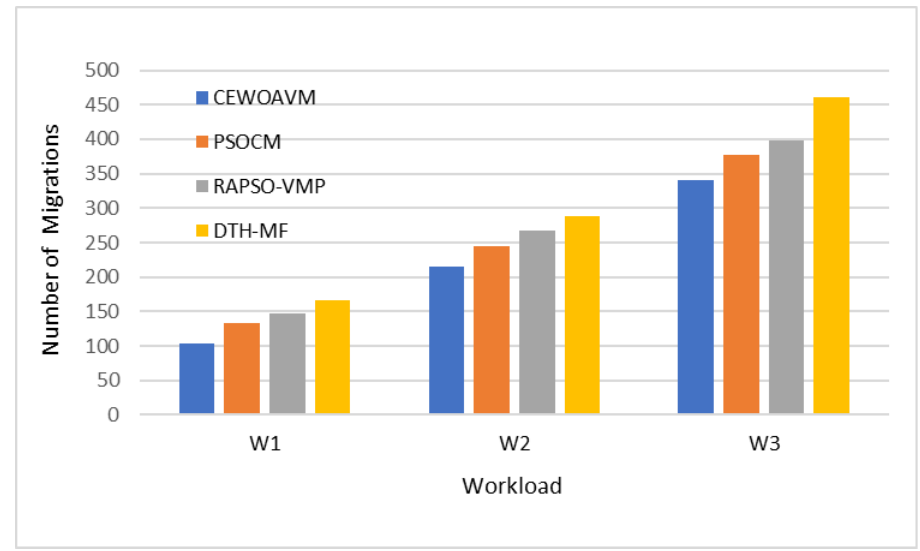
Figure 4. Comparison analysis of VM migration.